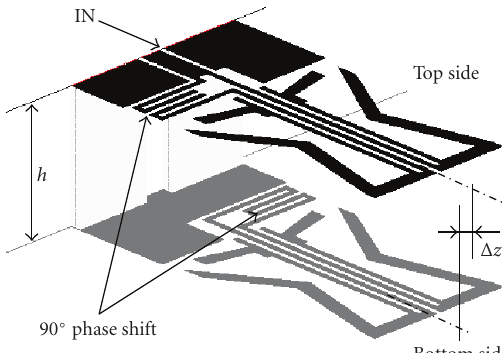
Figure 4: GPS omnidirectional